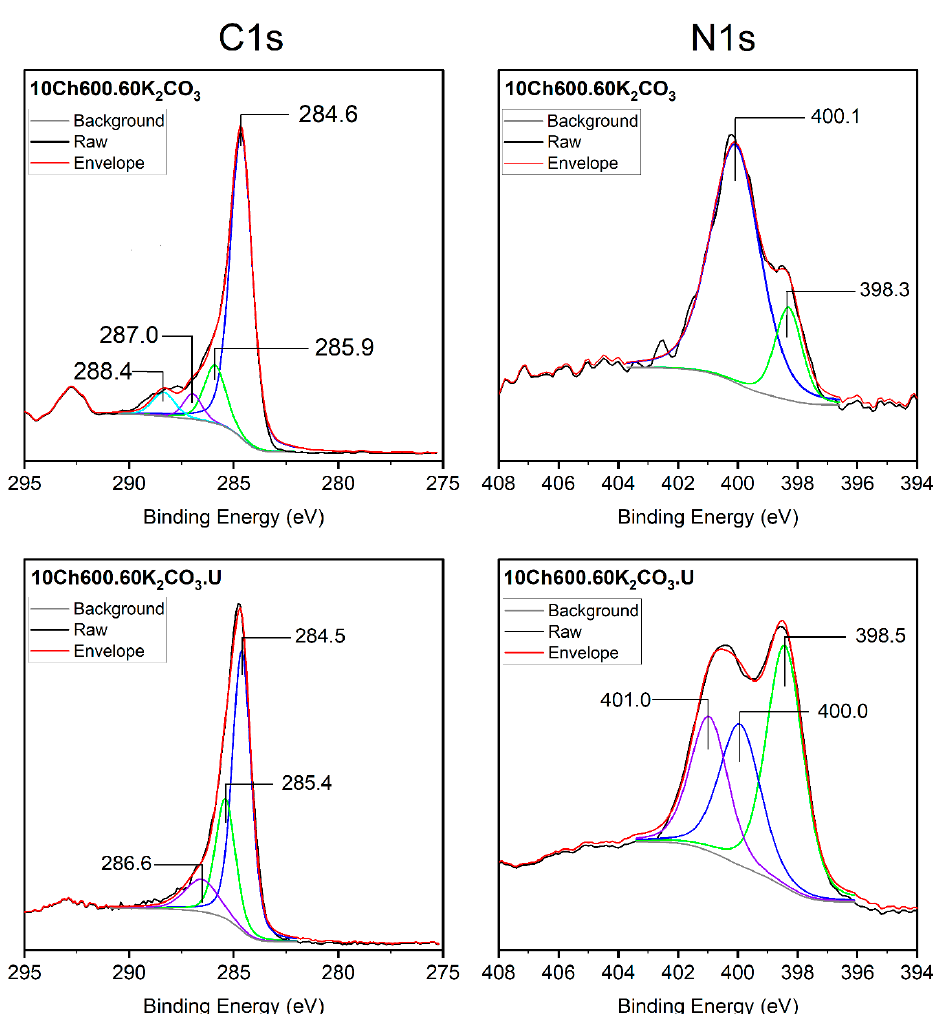
Figure 3. XPS C1s ( left ) and N1s ( right ) of Ch-based AC before and after functionalization with urea. Gray lines are the non-linear ‘Smart Backgrounds’ as been determined by the XPS instrument software, black lines are the raw data spectrum, and red lines are the reproduced envelope for the transition.